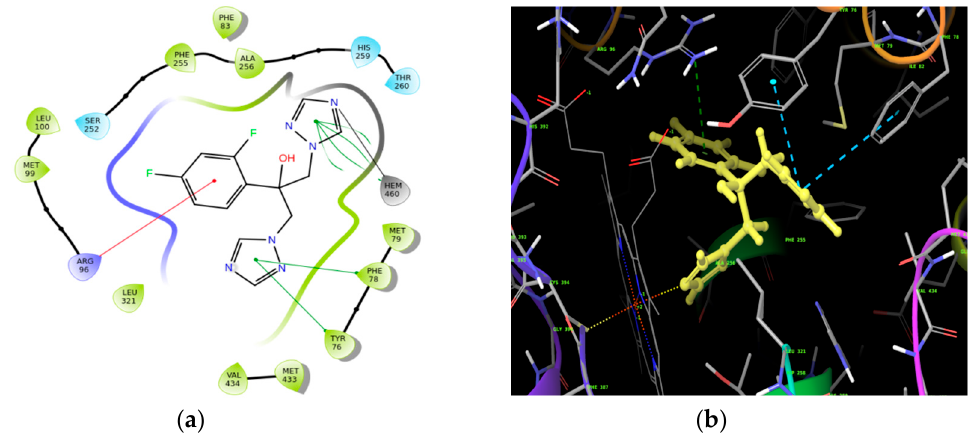
Figure 1. ( a ) 2D and ( b ) 3D docking pose of the standard drug fluconazole with MTCYP51.